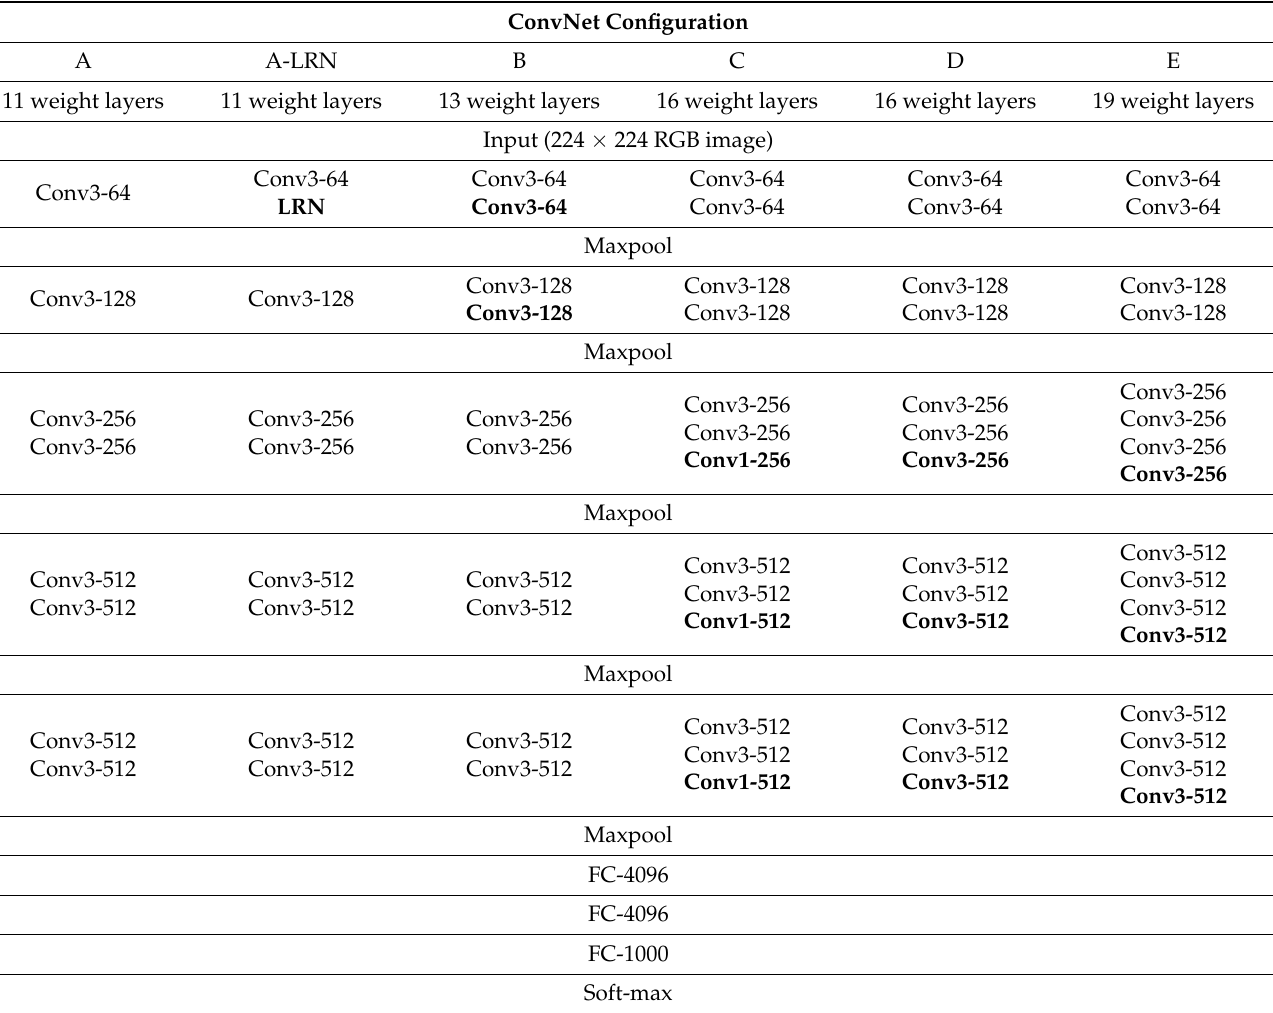
Table 2. Model Structure.